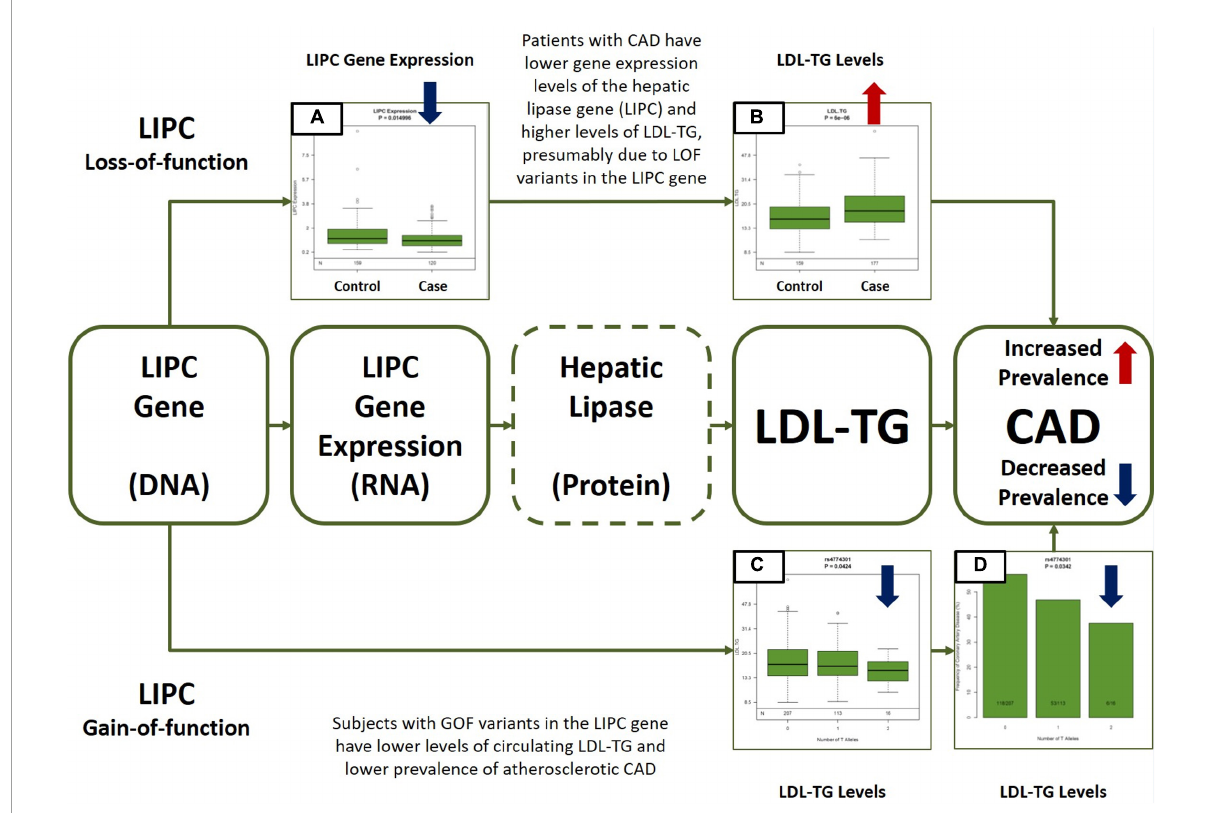
FIGURE5 Central Illustration. Multiomic Validation of the Hepatic Lipase (LIPC)/LDL-TG Axis in Atherosclerotic CAD along the Central Dogma of Biology. Gene expression levels of hepatic lipase (LIPC) are significantly lower (A) and circulating LDL-TG levels are significantly higher (B) in patients with atherosclerotic CAD, presumably due to LOF variants in the LIPC gene (upper part of the Figure). On the other hand, GOF variants in the LIPC gene are simultaneously associated with lower circulating LDL-TG (C) levels AND with lower prevalence of atherosclerotic CAD (D) . Except for hepatic lipase activity measurements (indicated by dotted line around hepatic lipase in the Figure), the GLOBAL study database contains all other multiomic measurements along the hepatic lipase/LDL-TG/atherosclerosis axis. The overall data presented here is consistent with our hypothesis that circulating triglyceride-rich LDL particles may have a potential causal role in atherosclerosis, due to abnormal hepatic lipase activity. LIPC, hepatic lipase; LDL-TG, low density lipoprotein triglycerides; CAD, coronary artery disease; LOF, loss-of-function; GOF,